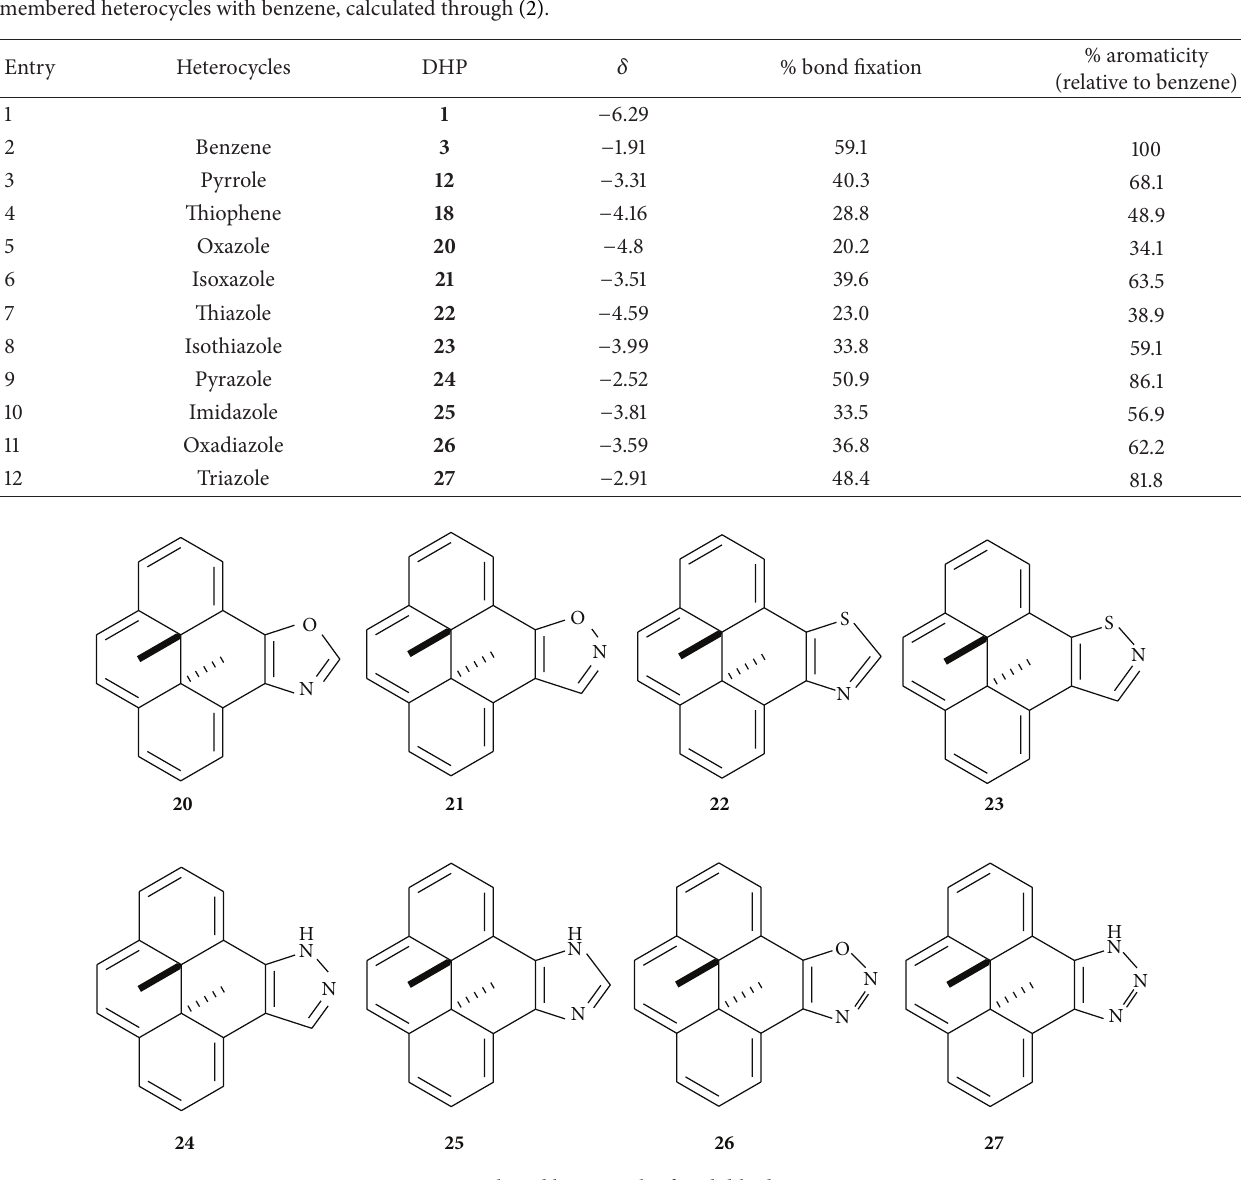
Figure 5: Five membered heterocycles fused dihydropyrenes 20 – 27